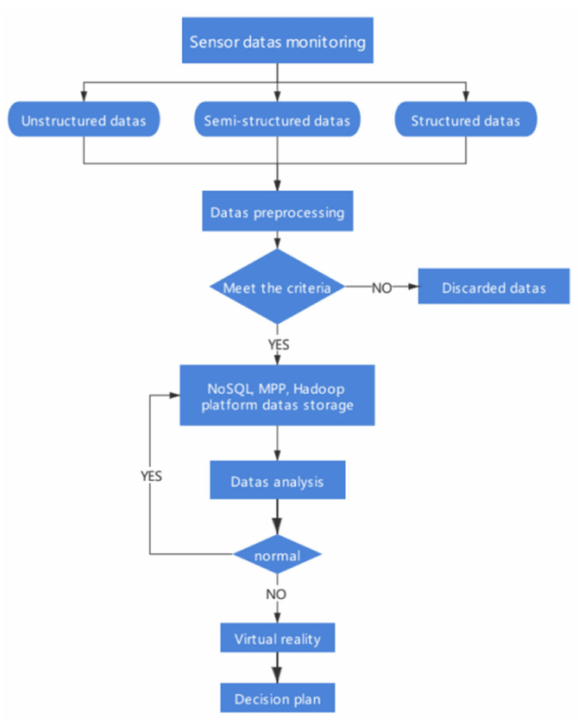
Figure 16. Data monitoring and analysis